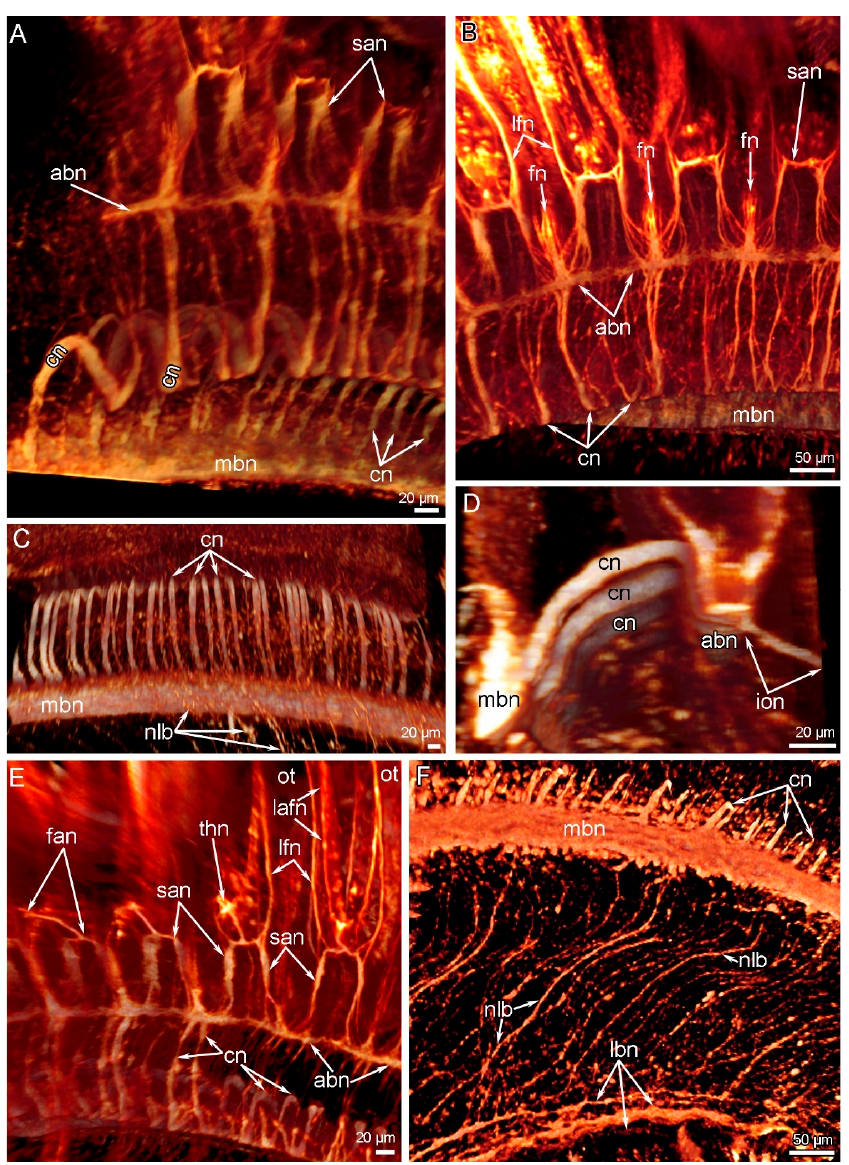
Figure 8. Volume rendering of the nerve elements of a part of the lophophore arm in Novocrania anomala adults. Reconstruction after immunostaining against acetylated alpha-tubulin. ( A ) Shape of cross nerves and their connection to the accessory brachial nerve. ( B ) Accessory and second accessory brachial nerves. ( C ) A portion of cross nerves, which extend along the bottom of the food groove. ( D ) Inner–outer nerve originating from the accessory brachial nerve. ( E ) Innervation of tentacles: frontal–abfrontal nerve and thick nodule are visible. ( F ) Nerves of the lophophore base that connect the main and lower brachial nerves. Abbreviations: abn—accessory brachial